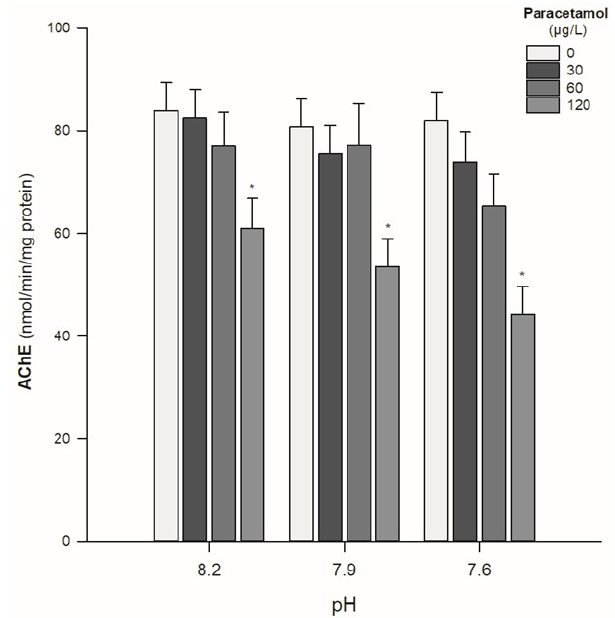
Figure 4. Acetylcholinesterases (AChE) activity in Hediste diversicolo r exposed to paracetamol (0, 30, 60, and 120 µg/L) under the pH values of 8.2, 7.9, and 7.6. Statistical differences among PAR concentrations (30, 60, and 120 µg/L) and the control group (0 µg/L) are represented with “*”.